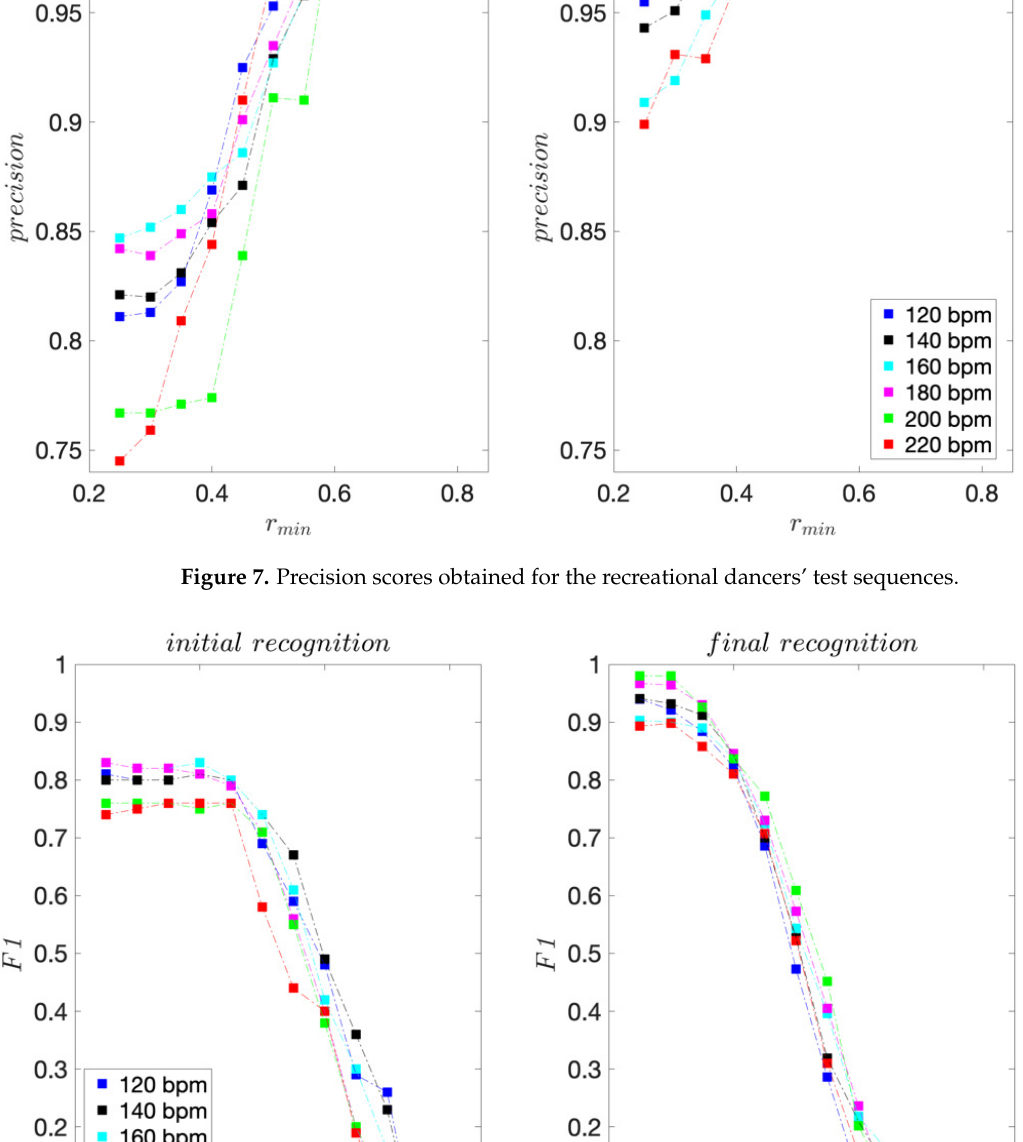
Figure 6. Sensitivity scores obtained for the recreational dancers’ test sequences.